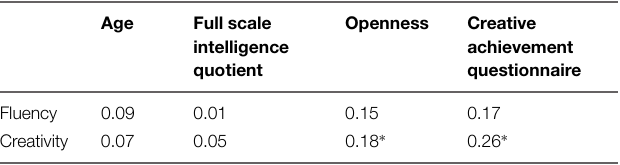
TABLE 1 | Bivariate relationships between Foresight measures of fluency and creativity.